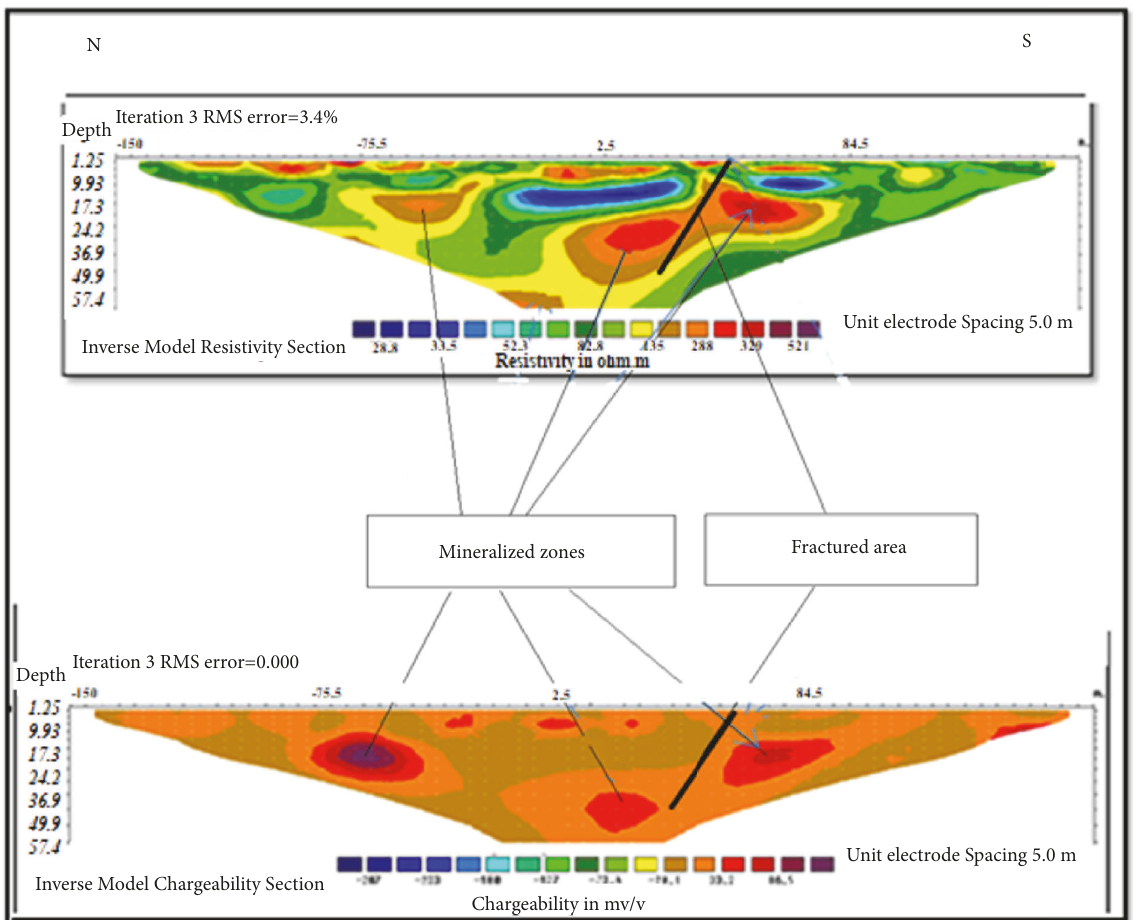
Figure 11: Inverse model resistivity and chargeability sections (Tabesbaste 1; direction: